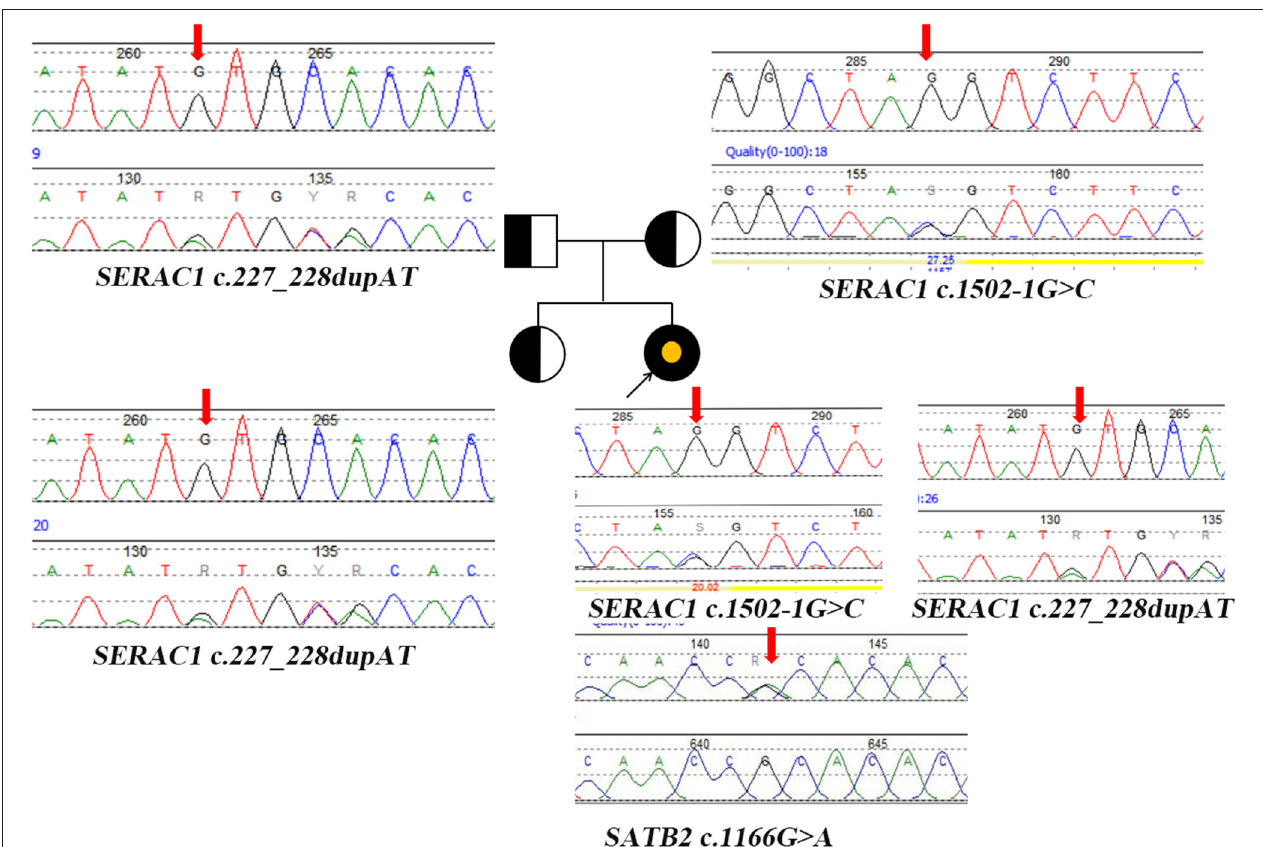
FIGURE 2 | Pedigree diagram and genetic characterization of the family with SERAC1 and SATB2 . Parents and sisters are heterozygous carriers of the SERAC1 gene; The yellow point represents the mutation of SATB2 gene. Heterozygous mutation (c.227-228dupAT) in SERAC1 was found in the patient, her father and her healthy sister. Heterozygous mutation (c.1502-1G > C) in SERAC1 was found in the patient and her mother. Heterozygous mutation (c.1166G > A) in SATB2 was only found in the patient; Red arrow indicate location of